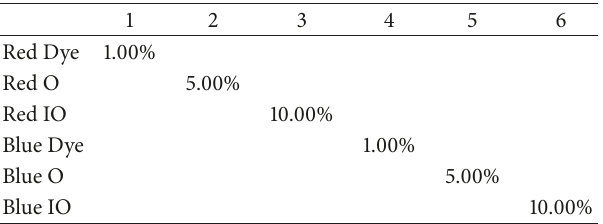
Table 1: The different colorants and their concentrations in the masterbatches of the first test series.